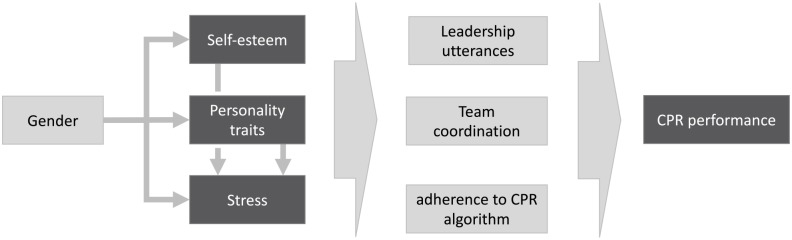
Hypothesized relationships between gender, psychological variables and CPR performance.